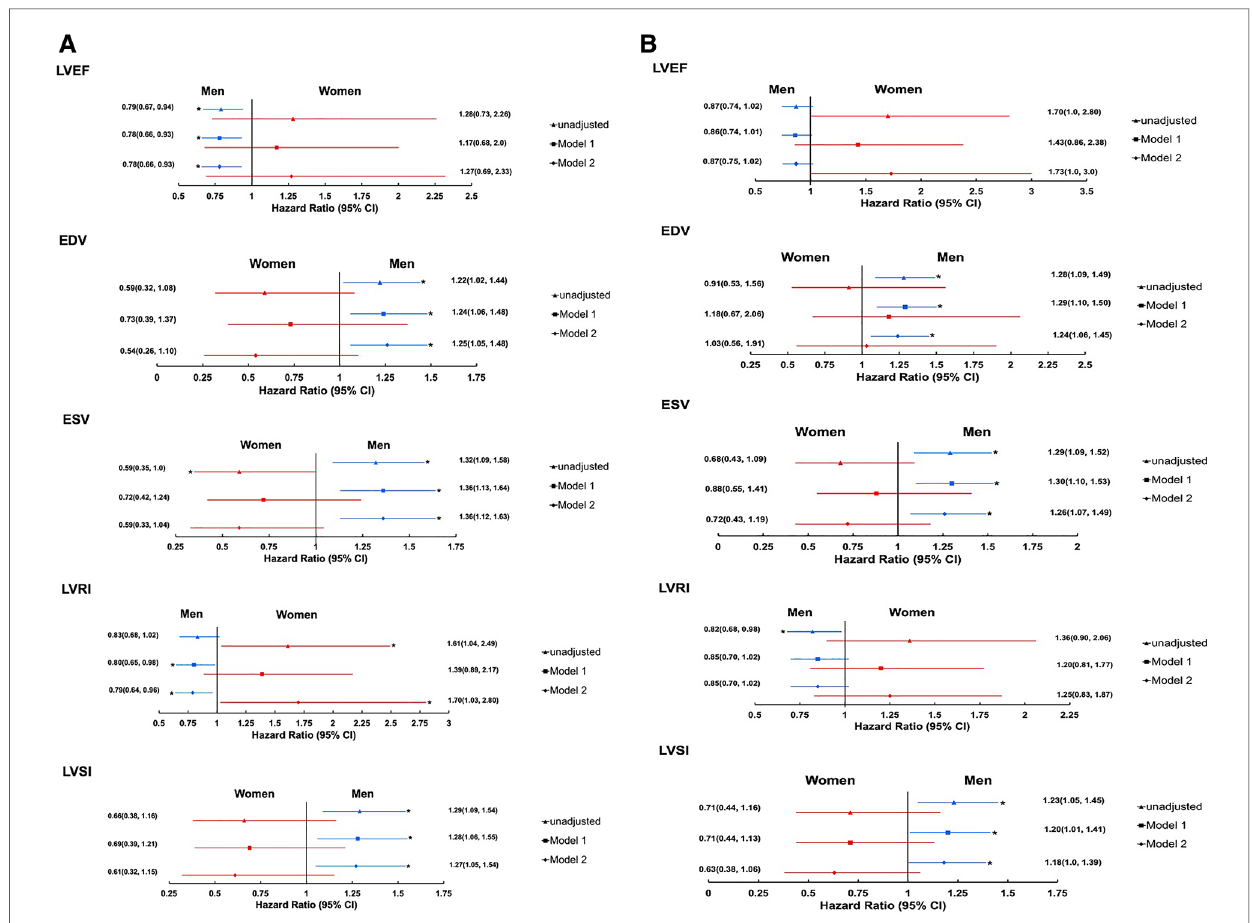
FIGURE 1 Forest plots showing the associations between 3DE LV measures, and all-cause mortality ( A ) and composite cardiovascular endpoint ( B ) strati fi ed by sex (imputed data). Estimates are HR(95% CI) per SD change. Model-1: adjusted for age and ethnicity. Model-2: model-1+systolic blood pressure, antihypertensive medication, cholesterol:HDL ratio, body mass index, diabetes mellitus, and smoking. 3D ESV is log transformed. Men: N =717(128 composite cardiovascular endpoints and 105 deaths of all-cause) for EF, EDV, and ESV; N =699(121 composite cardiovascular endpoints and 101 death of all-causes) for LVRI and LVSI (EF, SD=6.9%; EDV, SD=9.9 ml/m 2 ; ESV, SD=6.1 ml/m 2 ; LVRI, SD=0.37 g/ml; and LVSI, SD=0.086). Women: N =205(23 composite cardiovascular endpoints and 18 deaths of all-cause) for EF, EDV, and ESV; N =192(21 composite cardiovascular endpoints